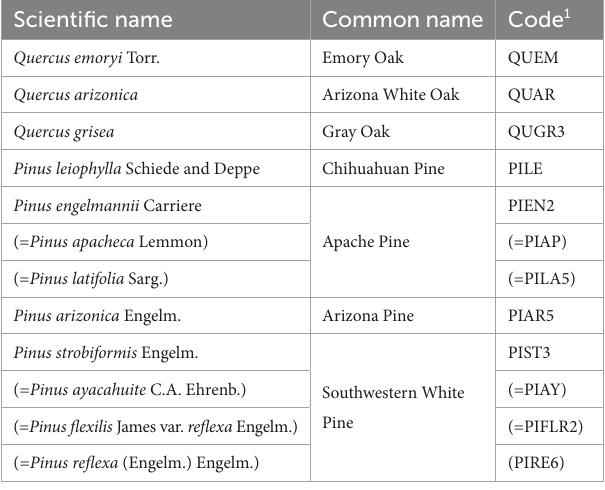
(=scientific name) and (=code) represent the alternative names and codes of synonymous trees. 1 Species codes refer to recognized abbreviations for species. Codes were acquired from